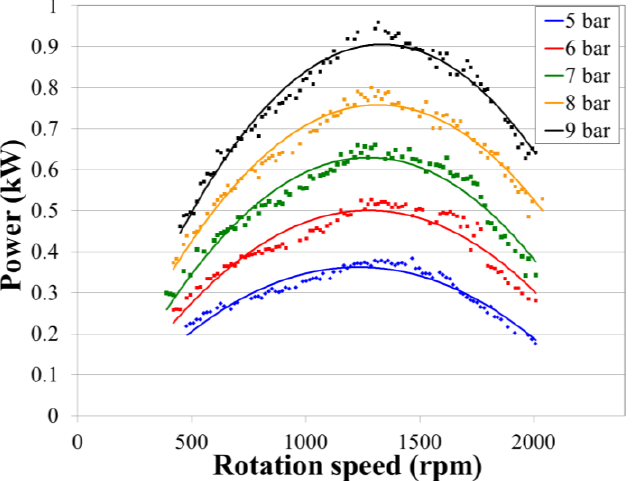
Figure 5. Power output of the compressed air engine at different rotation speeds and supplied air